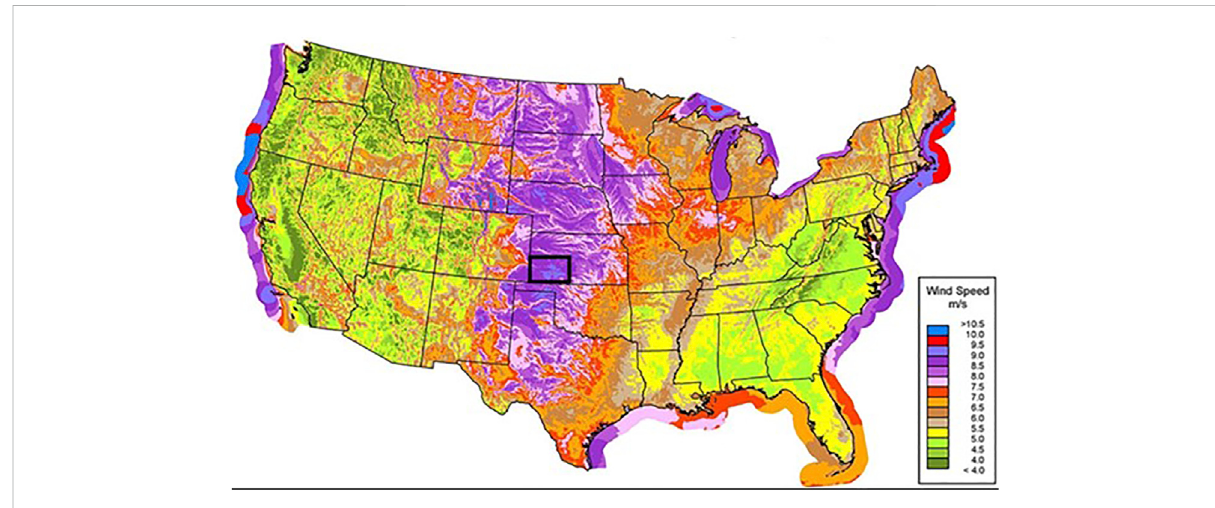
FIGURE 1 UnitedStates-Land-BasedandOffshoreAnnualAverageWindSpeedat100 m.Source:NRELandAWS TruePower(NRELandAWS Truepower LLC, 2013) with author modi fi cations.